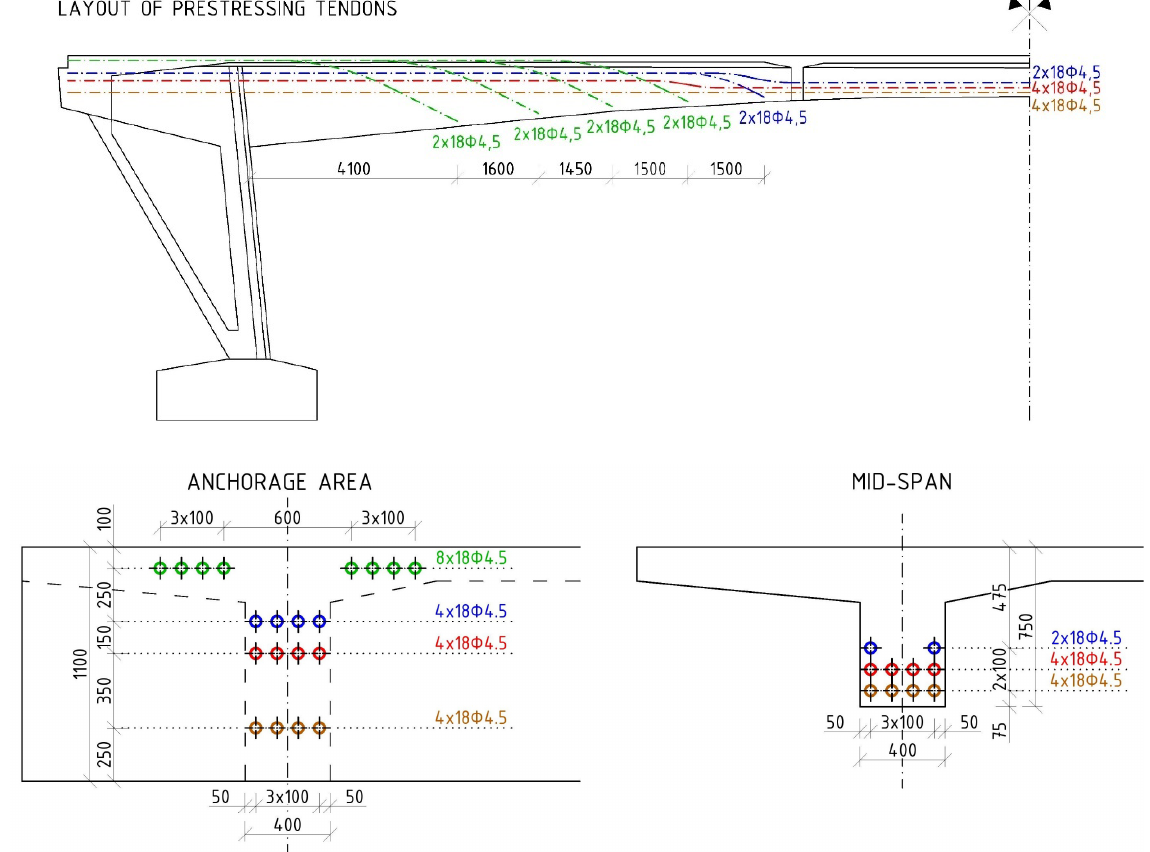
Figure 6. The layout of prestressing tendons (dimensions are in [mm]).